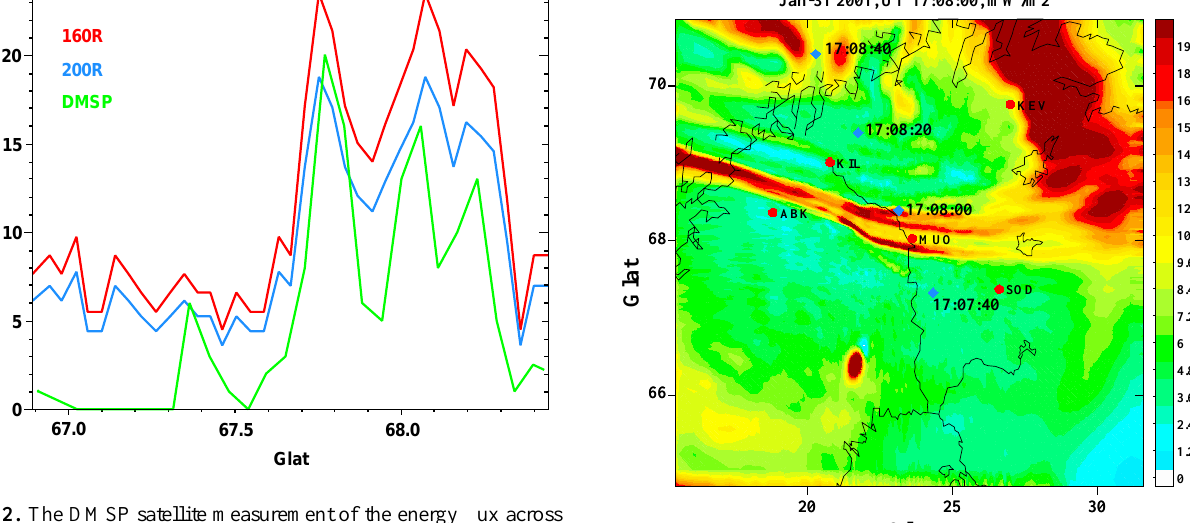
Fig. 2. The DMSP satellite measurement of the energy flux across the triple arc (green curve). As a comparison the red and blue curves show the energy fluxes calculated from the blue ASC image using the Eq. (8) and the blue photon yields of 160 and 200R /( mW / m 2 ) , respectively.